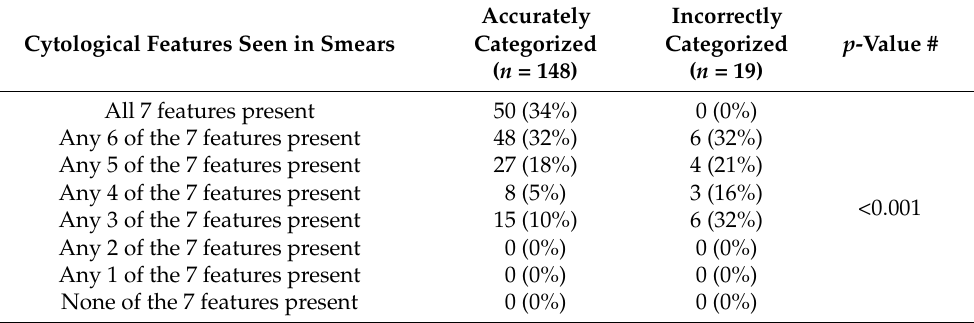
Table 4. The comparison of the presence of significant cytologic features between accurately and incorrectly diagnosed cases of MTC.